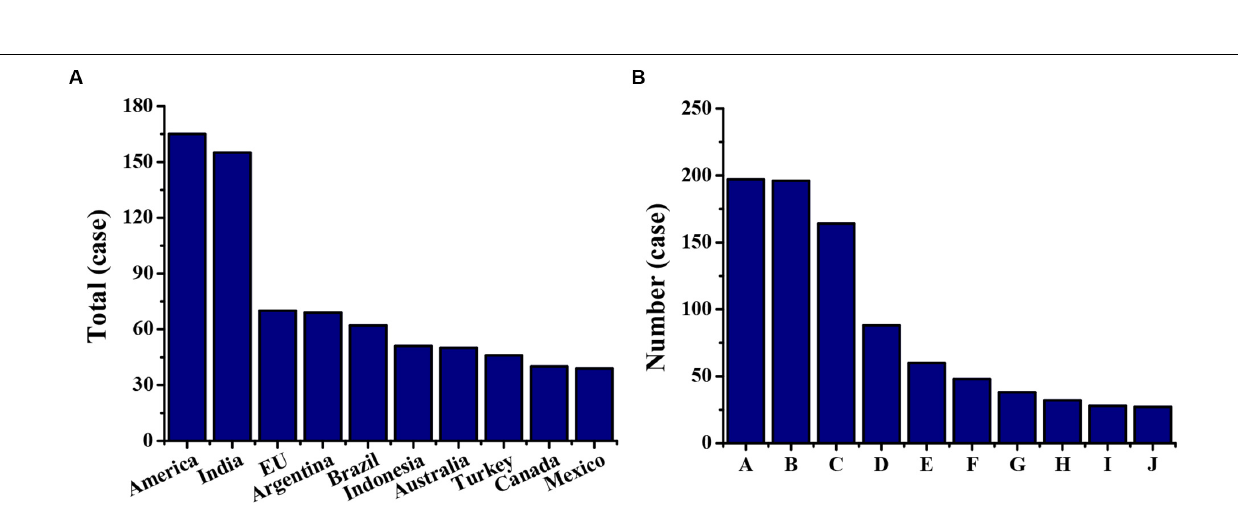
FIGURE 5 | The top 10 complaining countries and the complained industries in the China-related trade frictions in 2009–2019. Figure (A) is the top 10 complaining countries; Figure (B) is the top 10 complained countries; A is for the fabricated metal industry; B is for the steel industry; C is for the chemical raw material